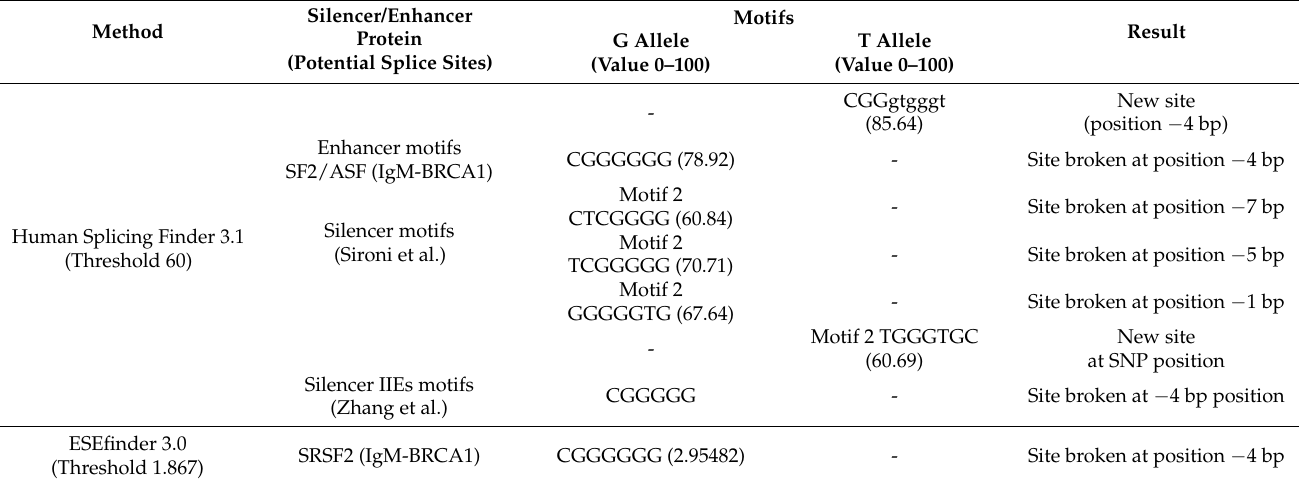
Table 9. ESEfinder3.0 and HSF3.1 prediction for SNP rs2004640 located in the IRF5 gene.